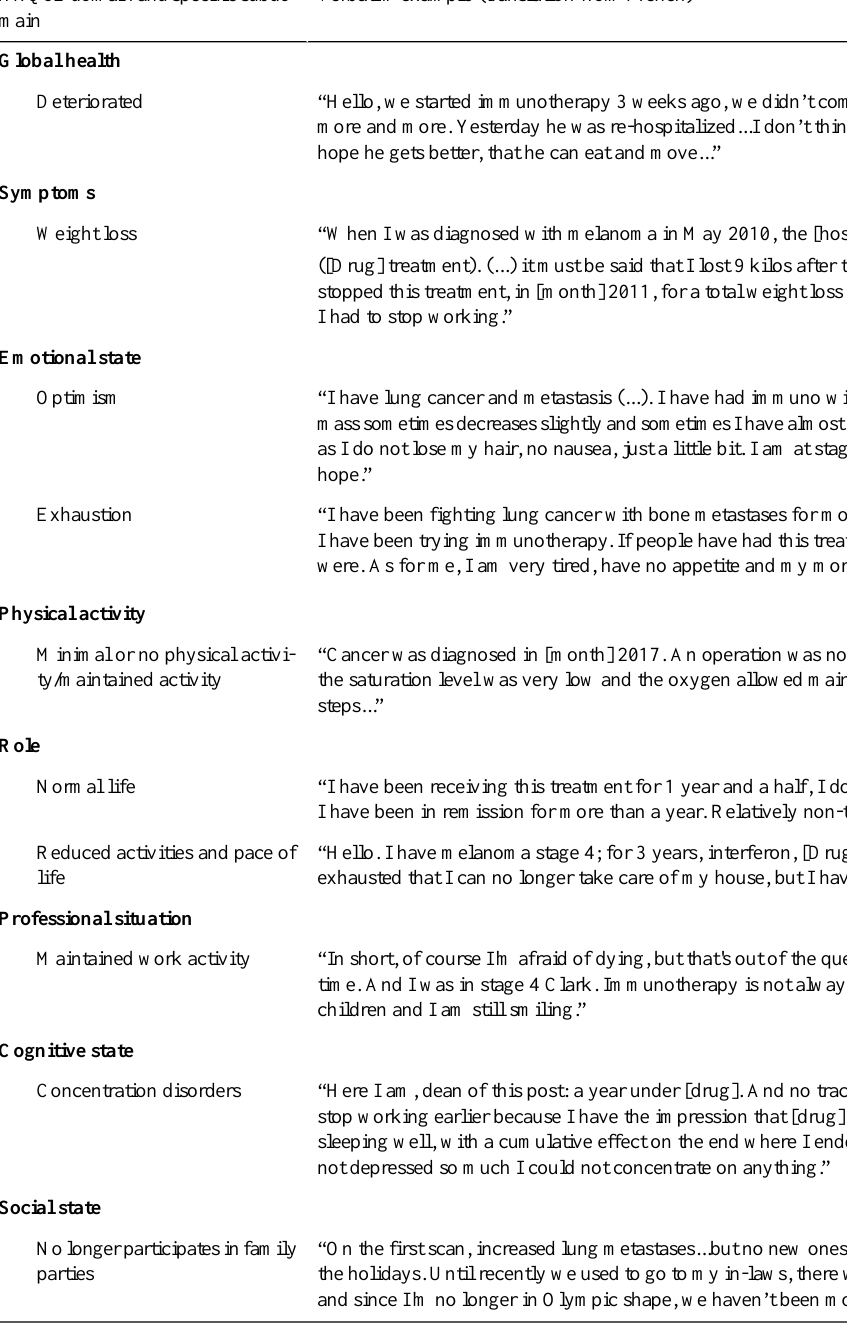
Table 2. Verbatim examples of posts related to HRQoL a of patients with cancer. Verbatim example (translation from French)HRQoL domain and specific